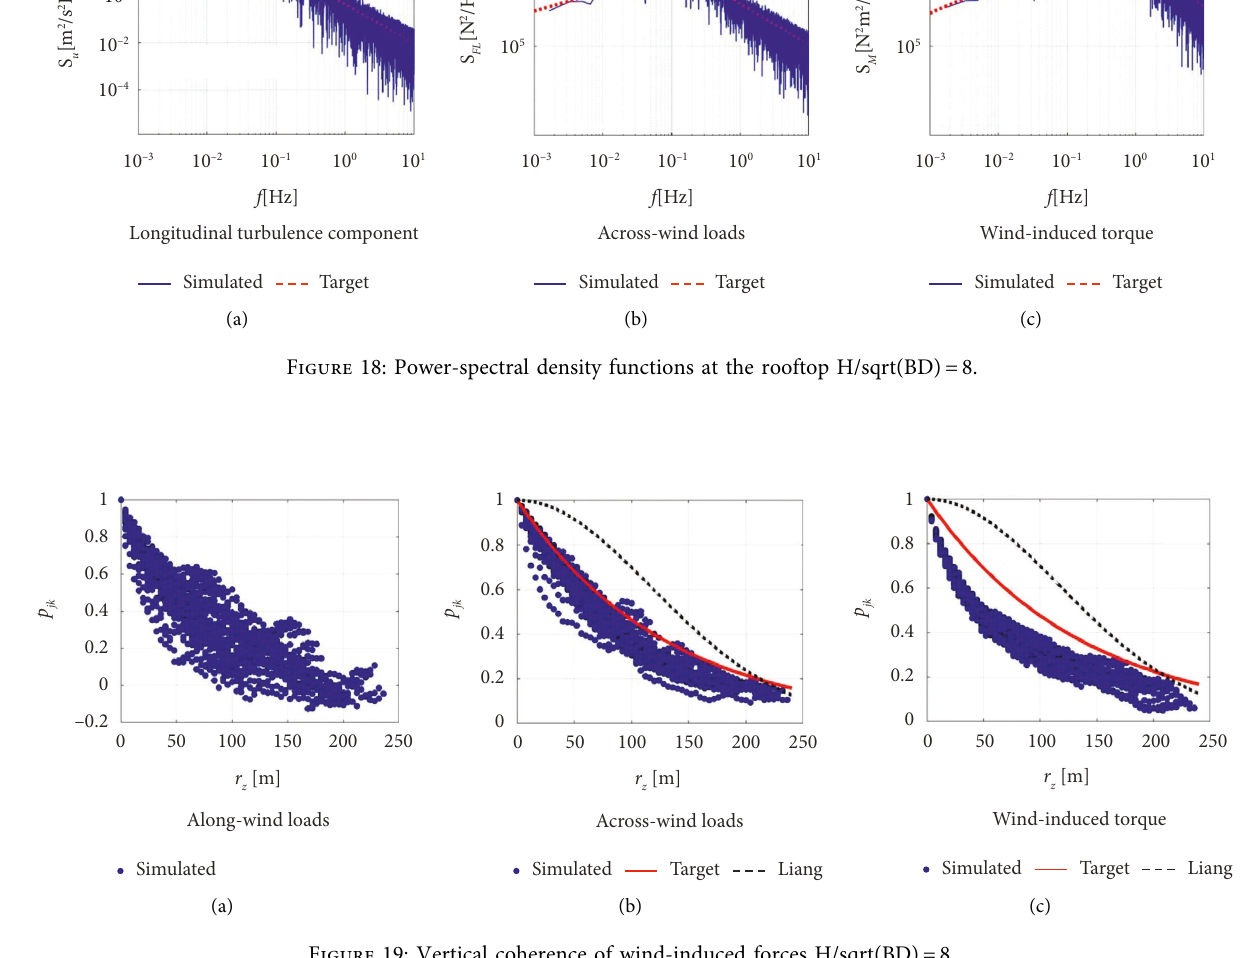
Figure 19: Vertical coherence of wind-induced forces H/sqrt(BD) � 8.